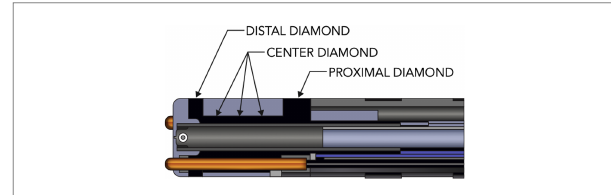
FIGURE 1 Diamondtemp TM catheter composite tip structure. The tip of the catheter consists of a diamond network — distal, proximal and center diamond. Three thermally isolated thermocouples protrude from the distal tip to ensure enhanced tip-tissue interface temperature readings; another 3 thermocouples are embedded in the proximal part to allow correct